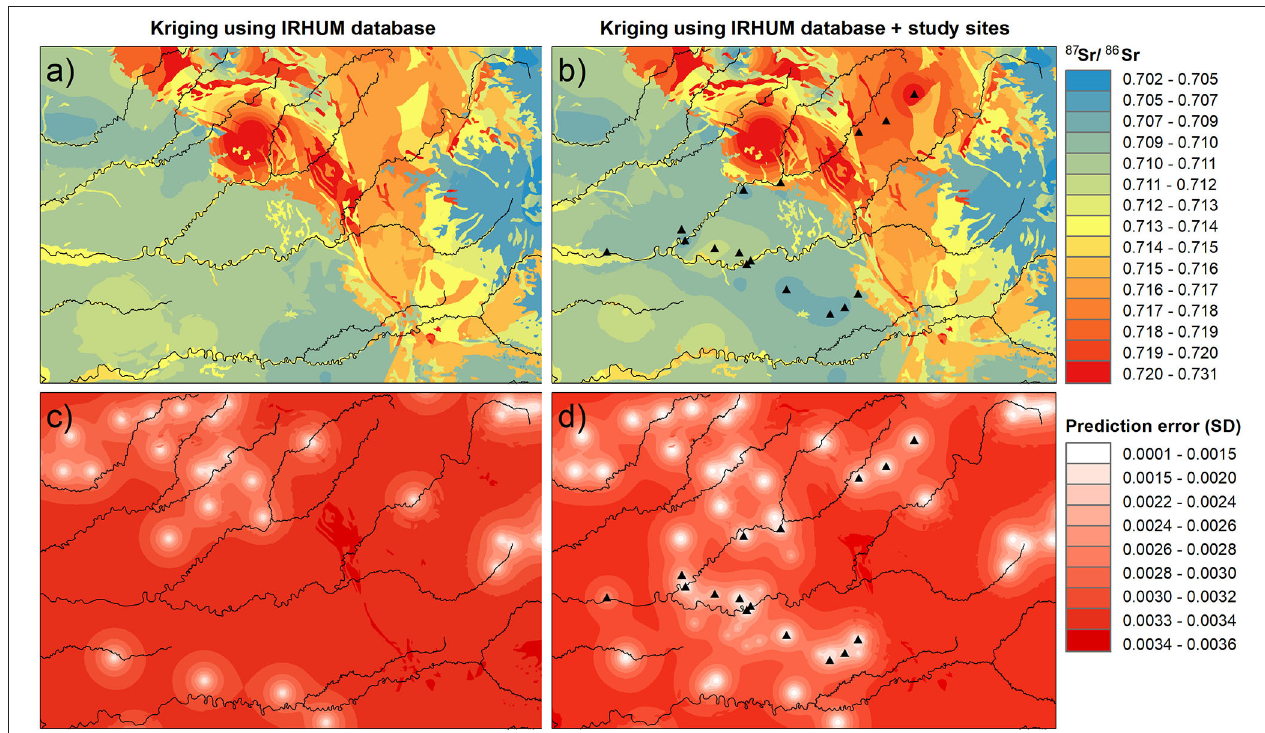
FIGURE 7 | Averaged 87 Sr/ 86 Sr isoscapes of plant and soil 87 Sr/ 86 Sr isoscapes generated by kriging with external drift using IRHUM sites (a) and IRHUM and sites in this study (b) , and their respective kriging prediction error maps (c,d) . Kriging prediction error is given as the standard deviation. Plant sampling sites are indicated by